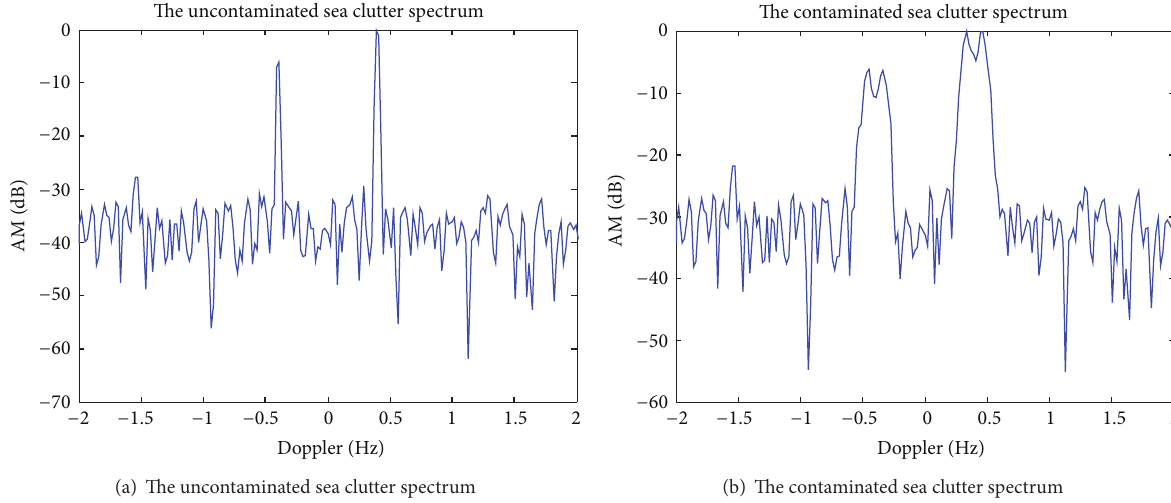
Figure 1: The uncontaminated and the contaminated sea clutter